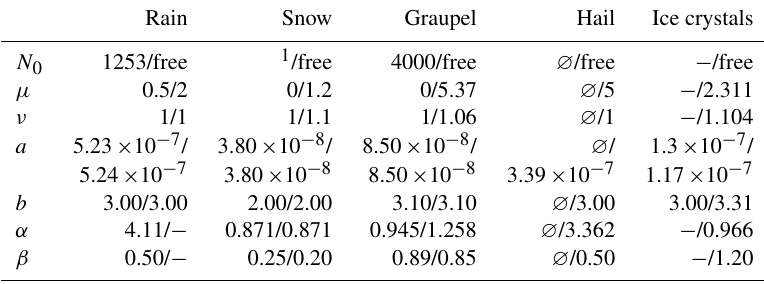
Table 1. Parameters of the hydrometeor PSDs and power-laws for the two microphysical schemes (separated by a slash sign). ∅ indicates that the hydrometeor is not simulated in this scheme, a dash indicates that this parameter is not used in this parameterization, and “free” indicates a prognostic parameter. As in Eq. (1), N 0 is expressed in units of mm − 1 − µ m − 3 . Note that the value of µ for rain can be specified in the COSMO user set-up, 0.5 being the default value. The parameters a and b correspond to the power-law: m(D) = aD b , with m is in kg and D in mm. The parameters α and β correspond to the power-law: v t (D) = αD β , with v t being the terminal fall velocity in ms − 1 , and D is the diameter in mm. Rain Snow Graupel Hail